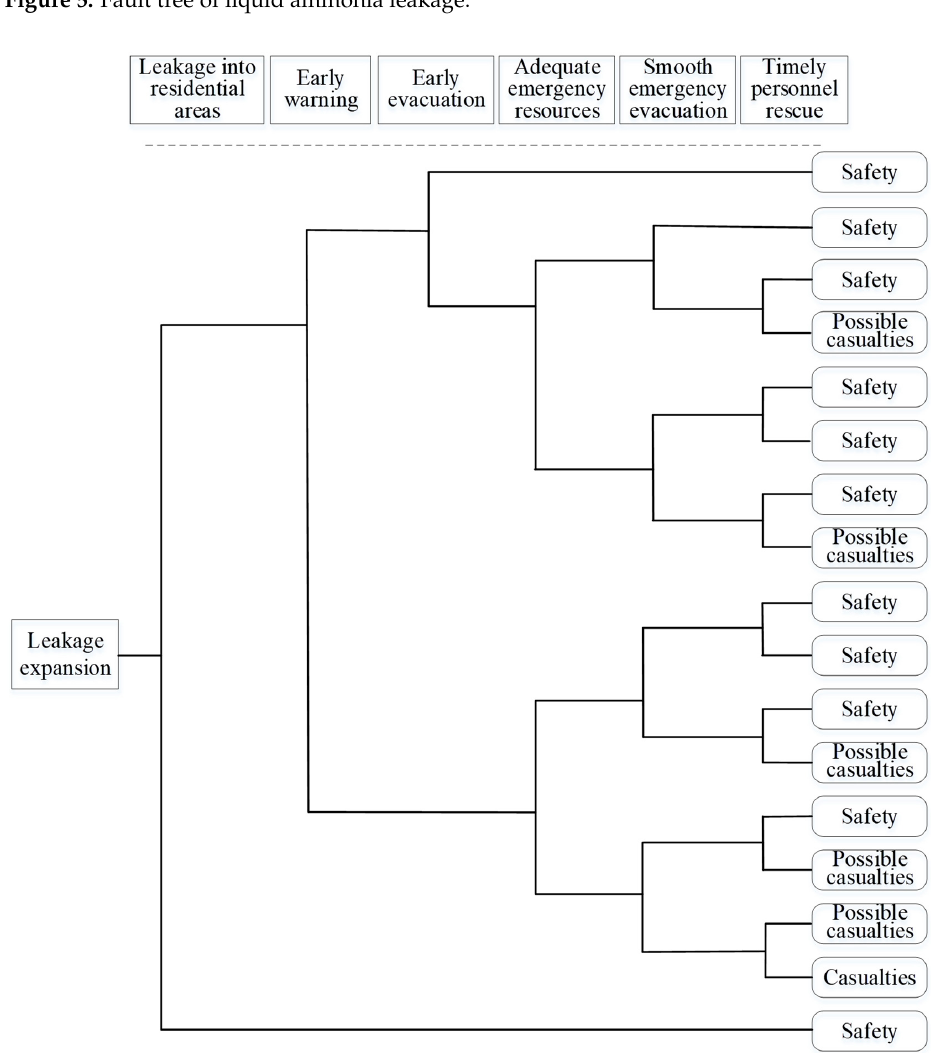
Figure 6. Residential area scenario event tree.